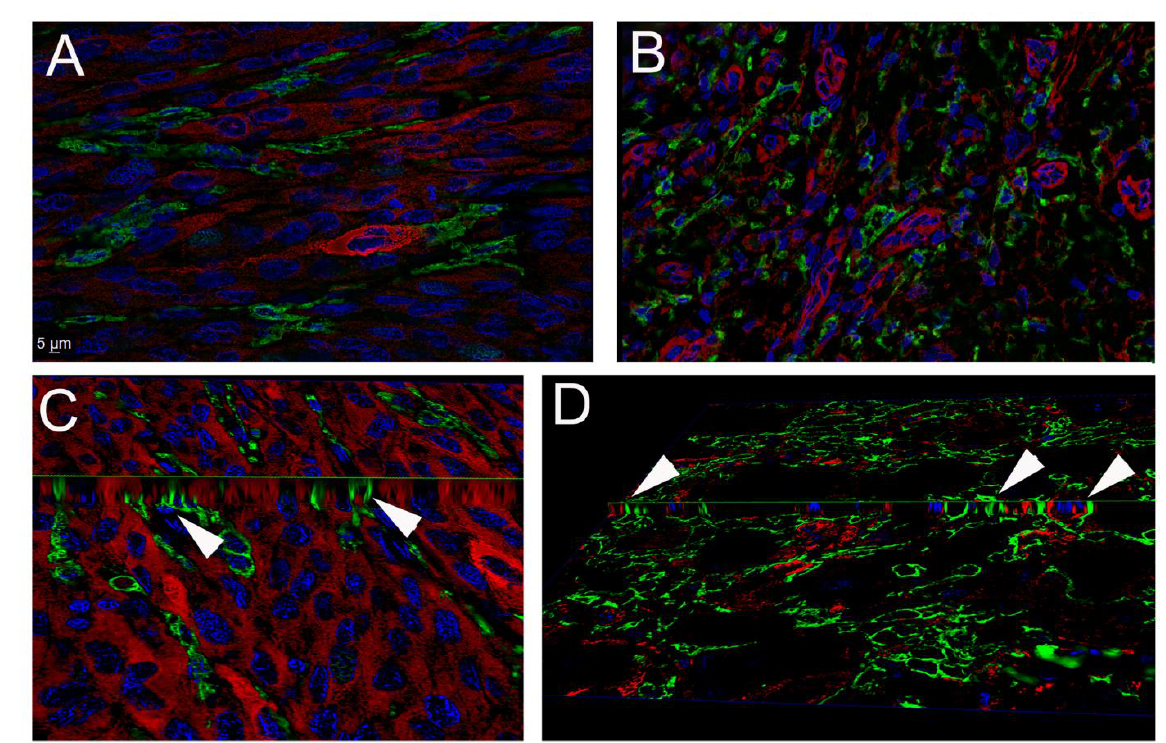
Figure 4. Immunohistochemistry of excised melanoma from two different patients. ( A , C ) Patient 1, ( B , D ) Patient 2. ( A , B ) The 0.5 µm thin optical sections from Z-stacks following deconvolution. ( C , D ) Images generated from slicing the three-dimensional Z stack; the arrows point at the intersection of the horizontal and vertical planes to demonstrate the very close connection between the membranes of Iba-1-positive macrophages (green fluorescence) and FAP-positive MAFs (red fluorescence). Blue fluorescence (DAPI) labels cell nuclei.